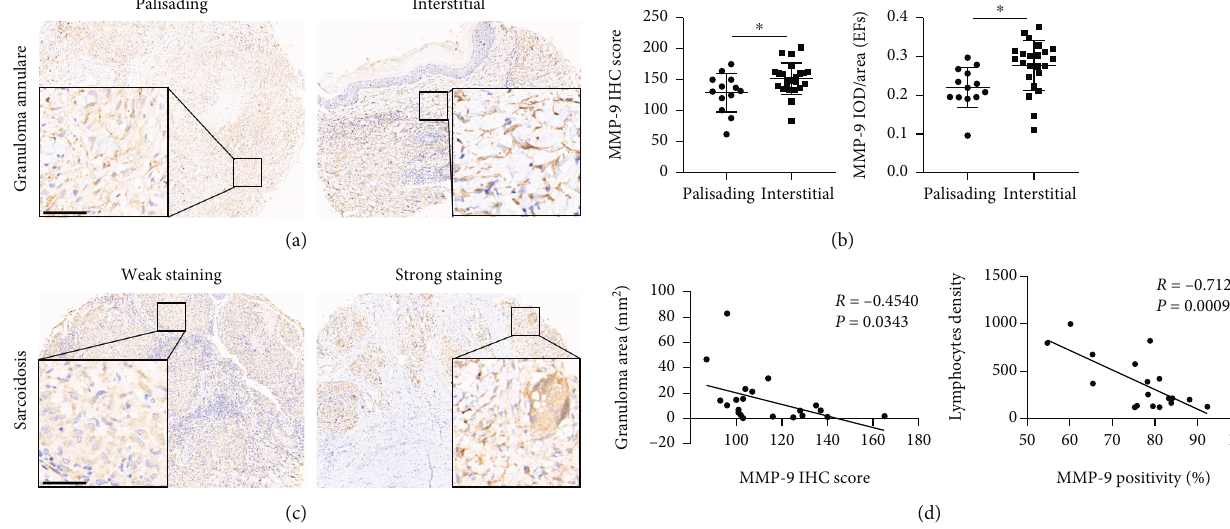
Figure 3: MMP-9 expression in granuloma annulare and sarcoidosis biopsies. (a) IHC staining of MMP-9 in palisading (left panel) and interstitial (right panel) GA, scale bar = 55 μ m . (b) Quanti fi cation of IHC staining for MMP-9 in patients with palisading and interstitial GA. (c) IHC of MMP-9 in sarcoidosis patients with weak (left panel) and MMP-9 strong (right panel) staining, scale bar = 55 μ m . (d) Correlation between MMP-9 expression and granuloma area and lymphocyte density in